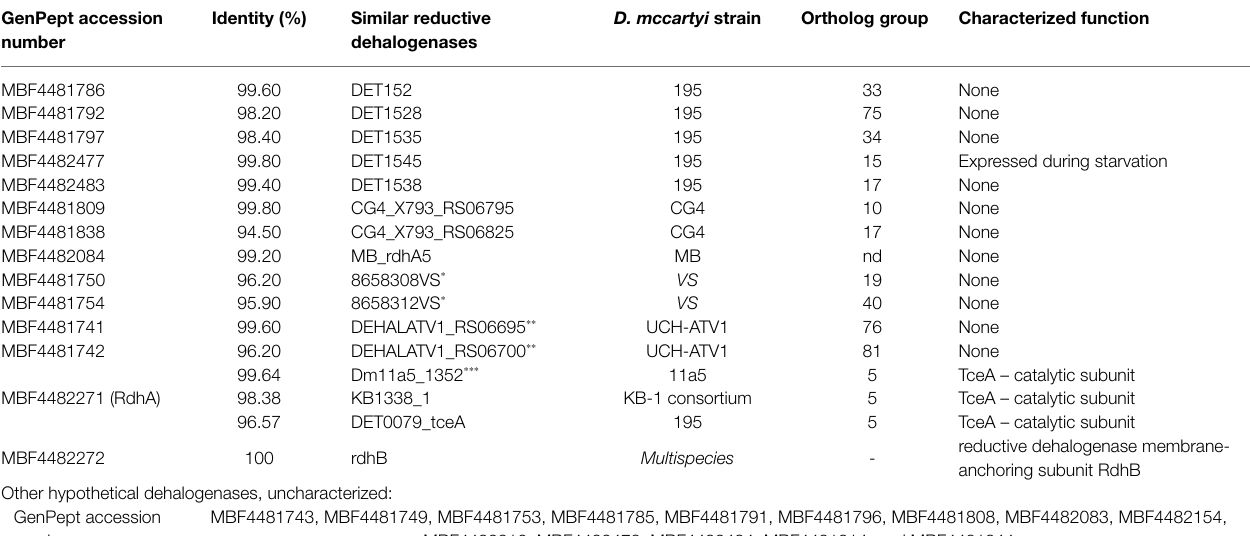
** Genes found in Dehalococcoides sp. genome where genomic rearrangement occurred during culture (Yohda et al., 2017). *** Gene from D. mccartyi strain 11a5 where a circular extrachromosomal genetic element and a new tetrachloroethene reductive dehalogenase gene were found (Zhao et al., 2017).